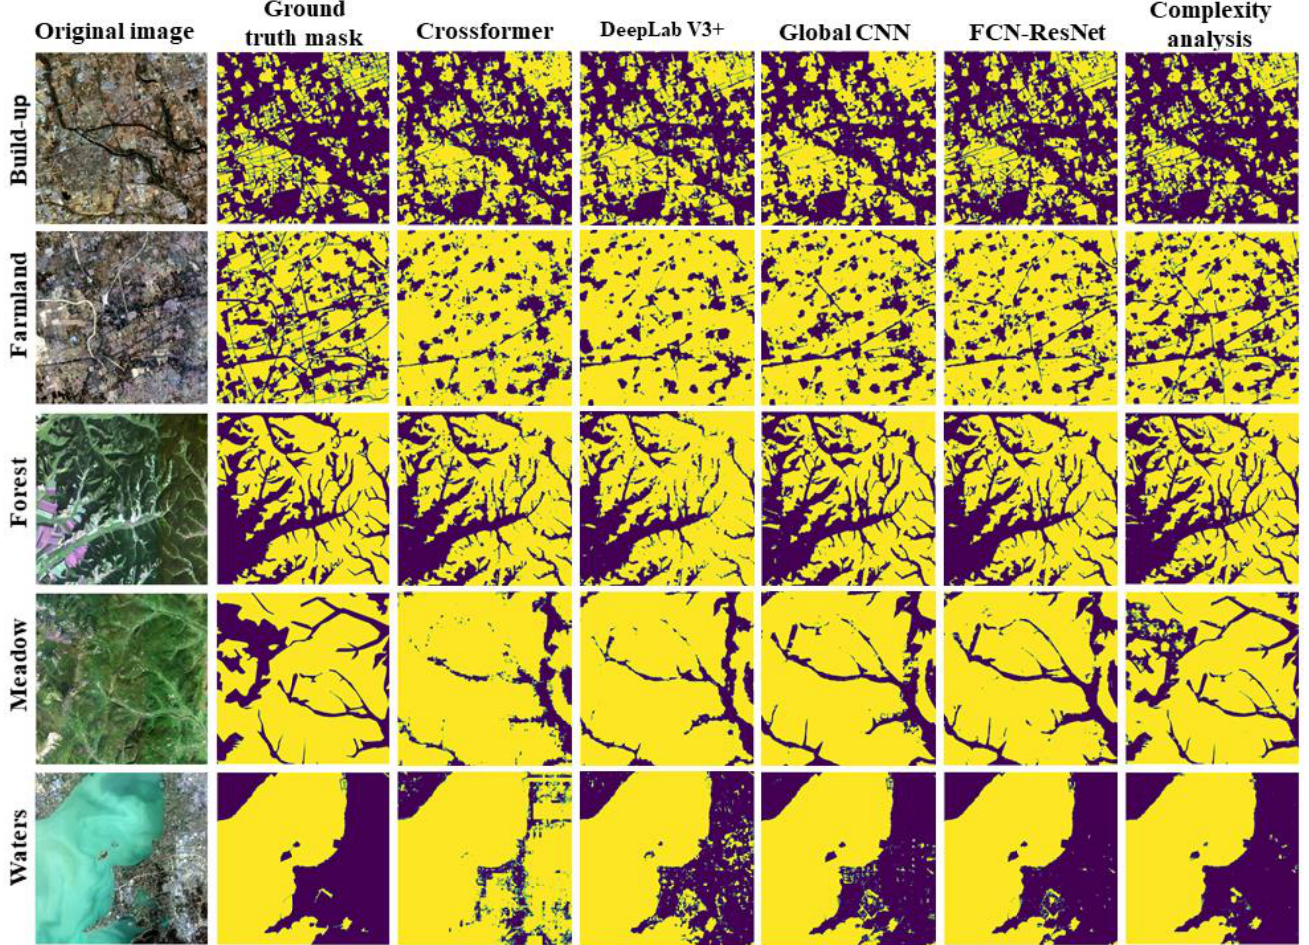
Figure 14. Comparison of segmentation results for Crossformer, DeepLab V3+, Global CNN, FCN- ResNet, and our complexity analysis.